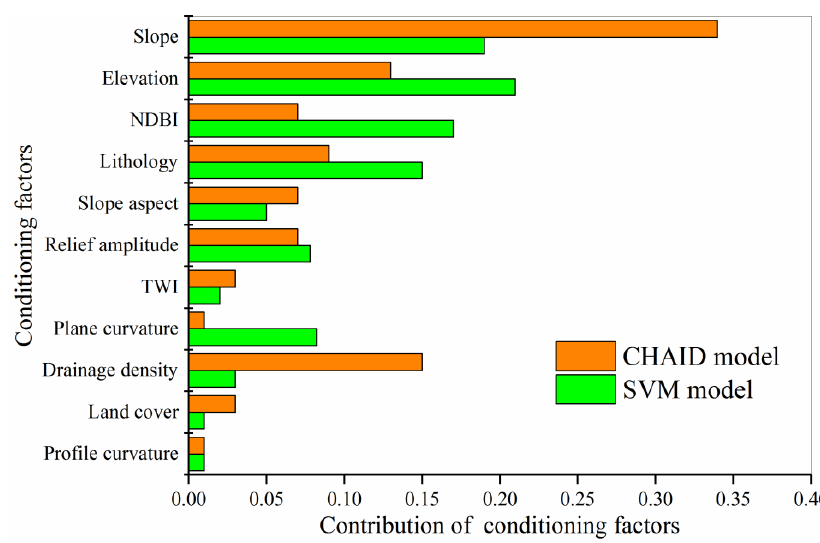
Figure 8. Relative importance of conditioning factors for SML models.